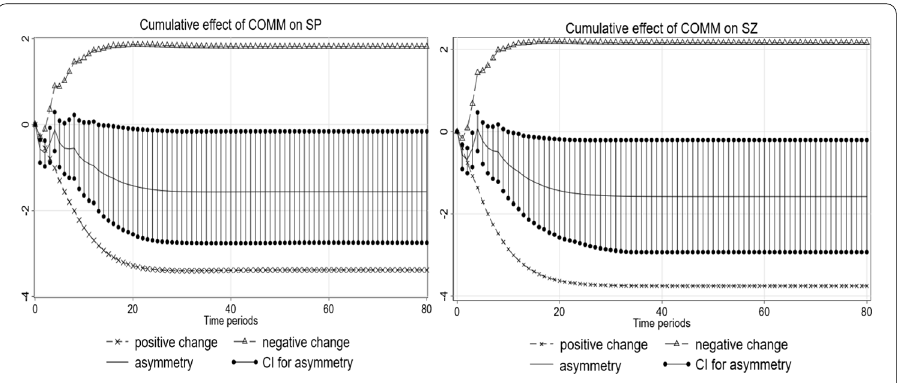
Fig.1 Dynamic multipliers of commodity prices on the Shanghai and Shenzhen Composite